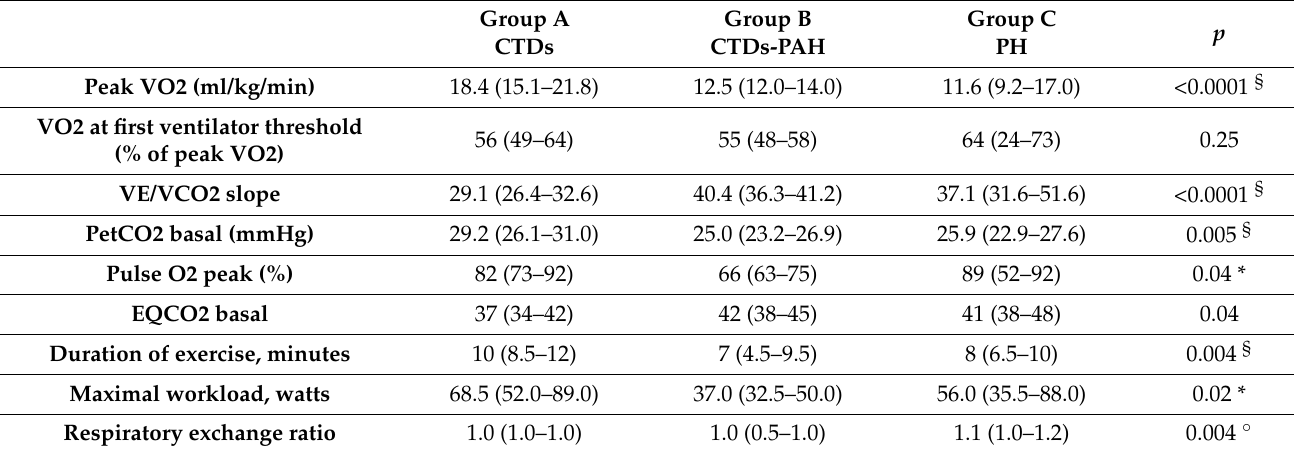
Table 2. Comparison of the main CPET parameters among groups between groups. For abbreviation: VO 2 , volume of oxygen uptake; VE, ventilation; VCO 2 , volume of exhaled carbon dioxide; PetCO 2 , end-tidal partial pressures for CO 2 .